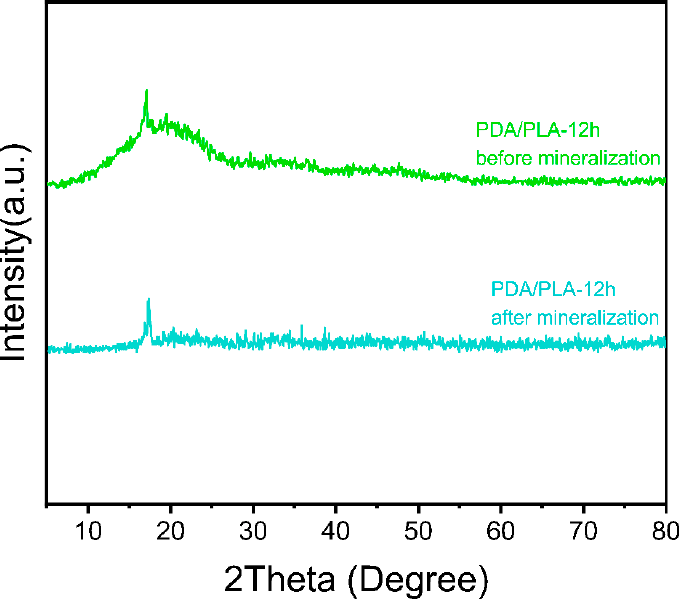
Figure 10. XRD pattern of PDA/PLA-12 h scaffold before and after mineralization.